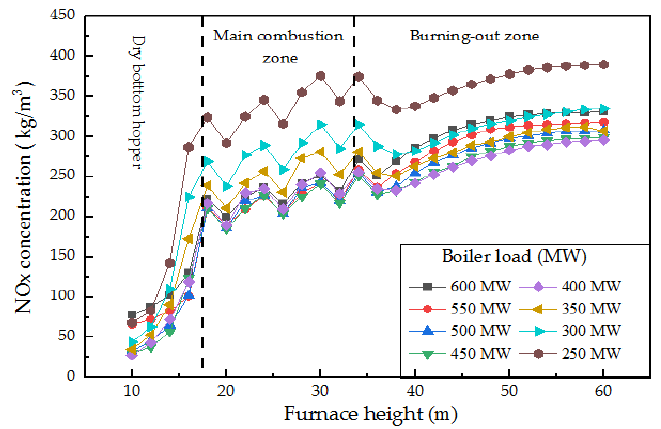
Figure 8. Variation in NOx concentration with boiler loads.